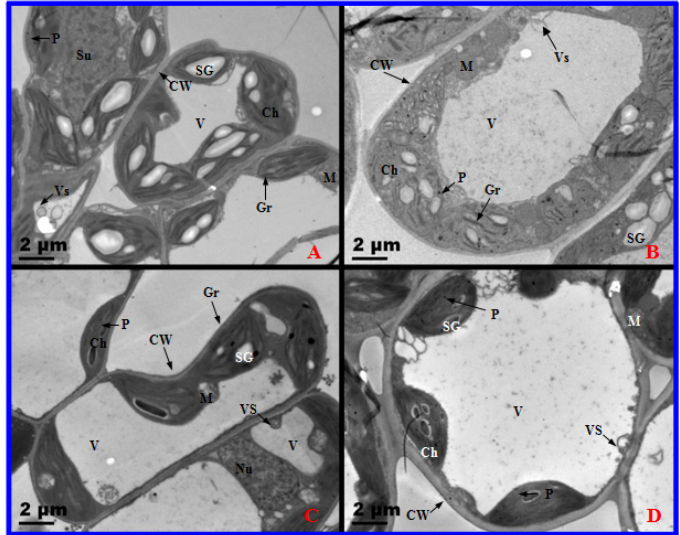
Figure 7. Transmission electron micrographs of diploid (2×) and tetraploid (4×) Robinia pseudoacacia mesophyll cells after one day and 10 days of salt treatment. ( A ) 0 day, 2×; ( B ) 0 day, 4×; ( C ) 10 days, 2×; ( D ) 10 days, 4×. CW, cell wall; Ch, chloroplast; M, mitochondrion; Nu, nucleolus; P, plastoglobule; SG, starch granule; Gr, granum; V, vacuole; Vs, small vesicle.